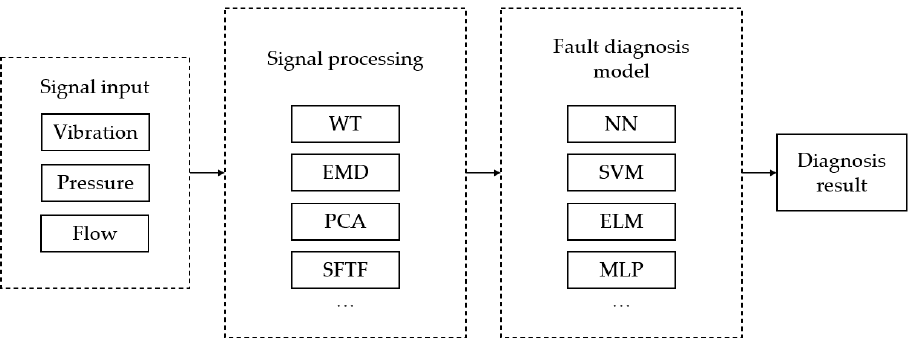
Figure 2. Fault diagnosis block diagram.